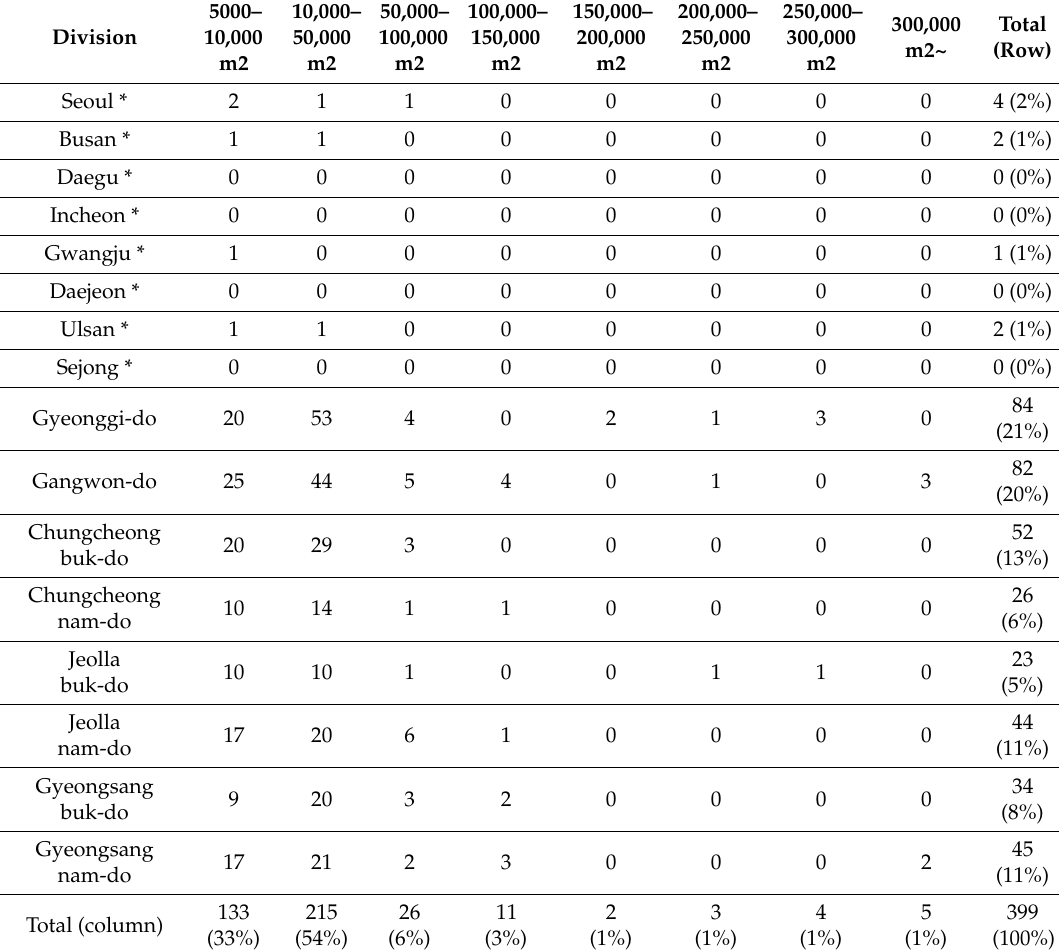
Table 4. Distribution status of damaged areas in South Korea derived through remote